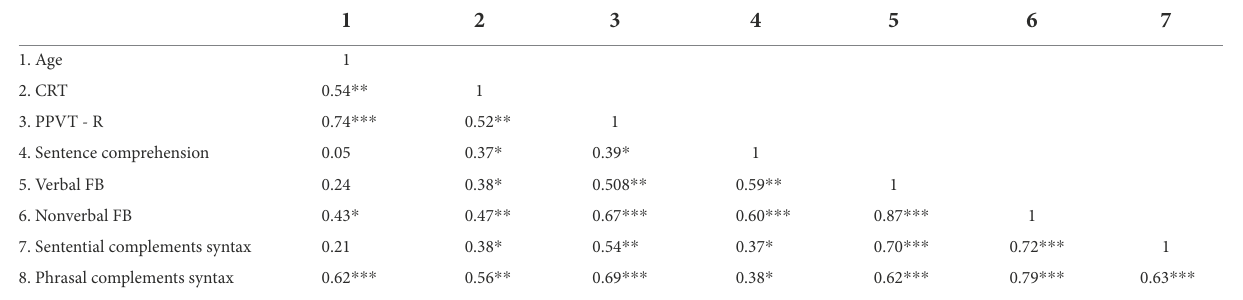
TABLE 1 Simple correlations results for the ASD